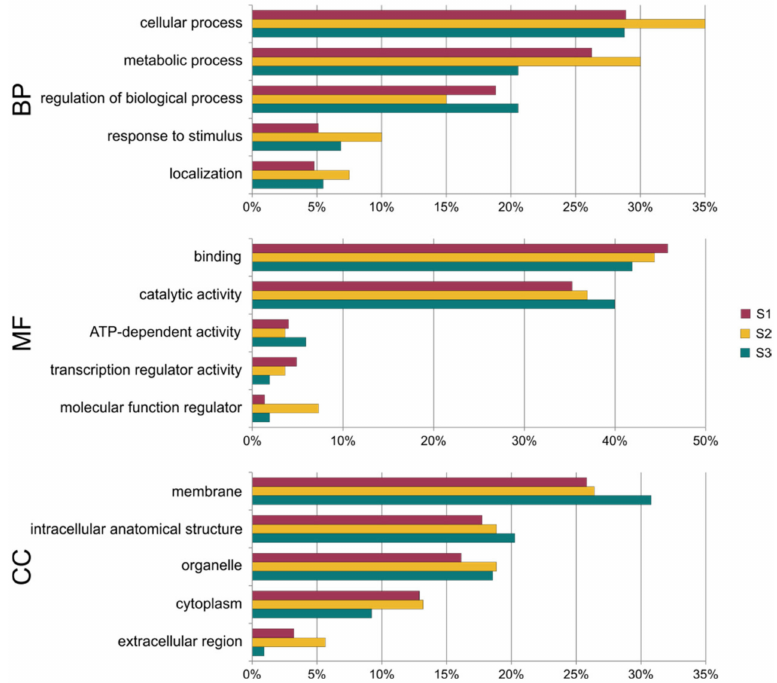
Figure 9. Percentage of GO terms assigned to target genes in three cucumber somaclonal lines (S1, S2 and S3). BP–biological process, MF–molecular function, CC–cellular compartment.